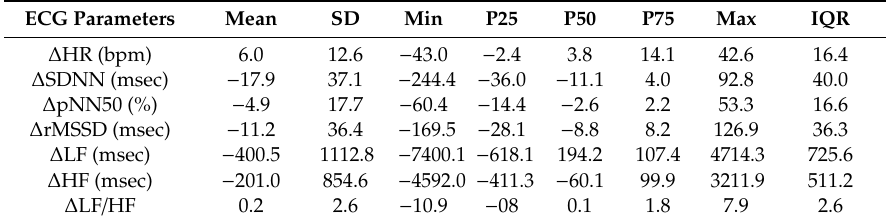
Table 3. Descriptive statistics of the variation di ff erence in 5 min window of ECG parameters 1 . ECG Parameters Mean SD Min P25 P50 P75 ∆ HR